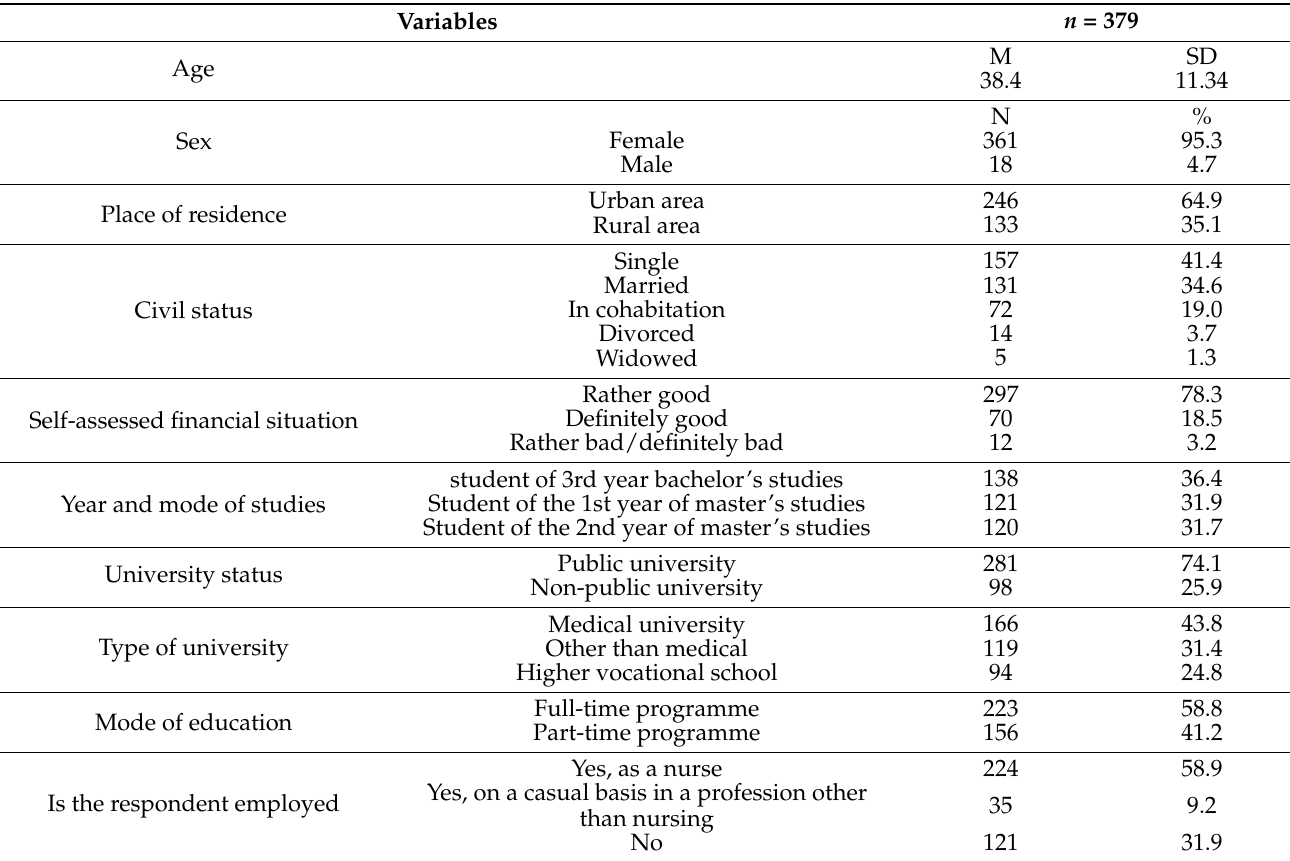
Table 1. Demographic and other selected variables of the nursing students ( n = 379).